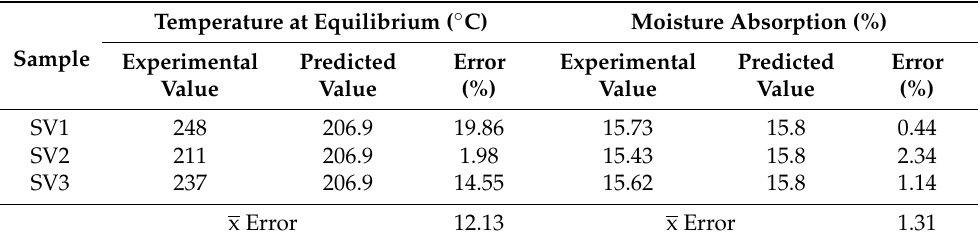
Table 8. Experimental validation for the temperature at equilibrium and moisture absorption proper- ties.